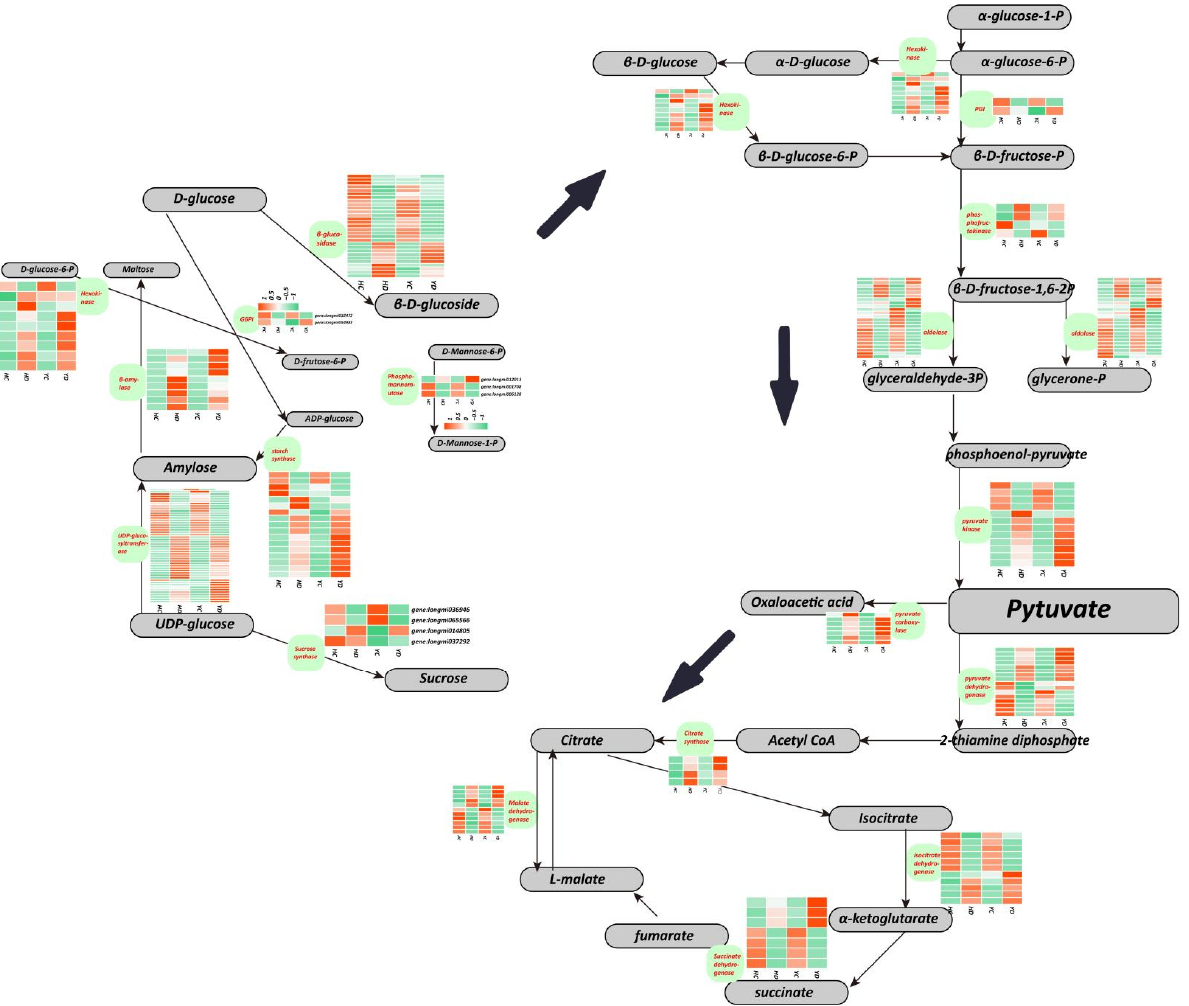
Figure 1. The expression profile of genes involved in sugar metabolism. These genes include starch and sucrose metabolism, glycolysis, and the TCA cycle, involving 21 related enzymes and regula ‐ tory